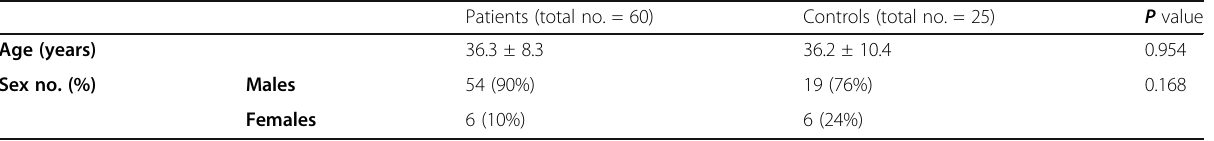
Table 2 Comparison between demographic features of BD patients and controls